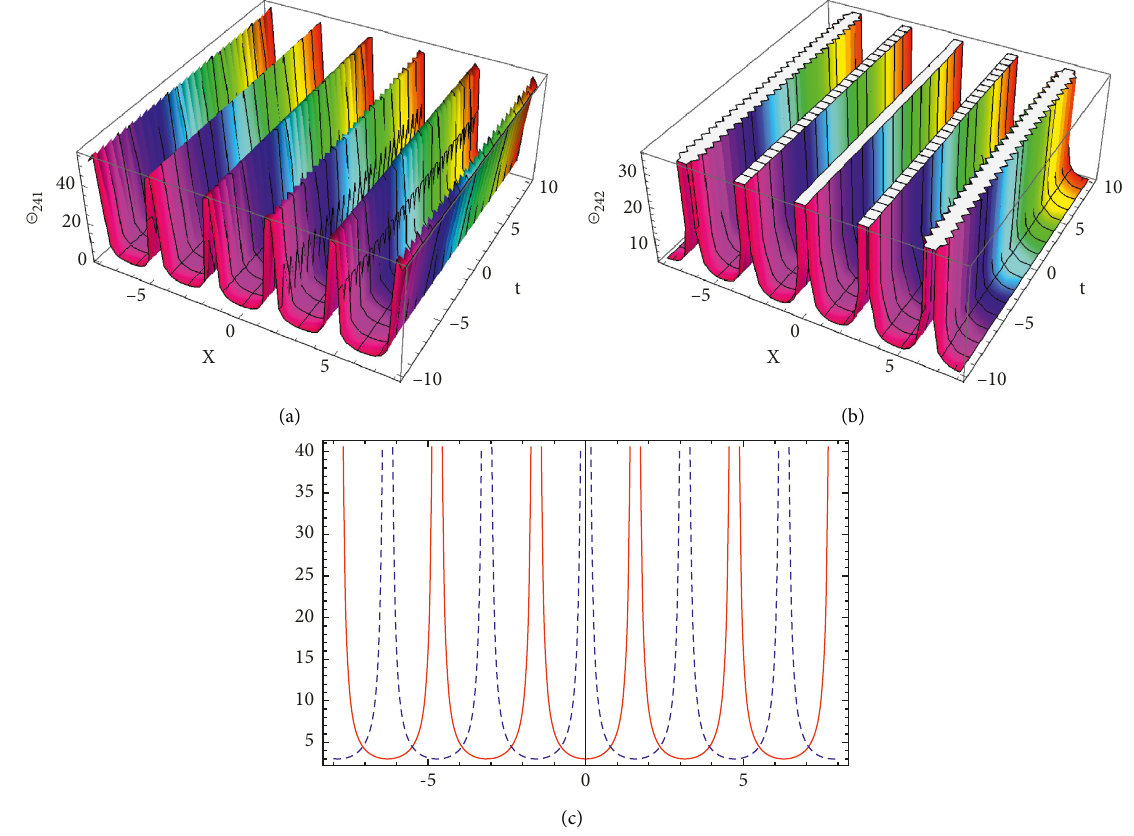
Figure 6: Plots of equations (65) and (66) for m � 2, ξ � 0 . 3, λ